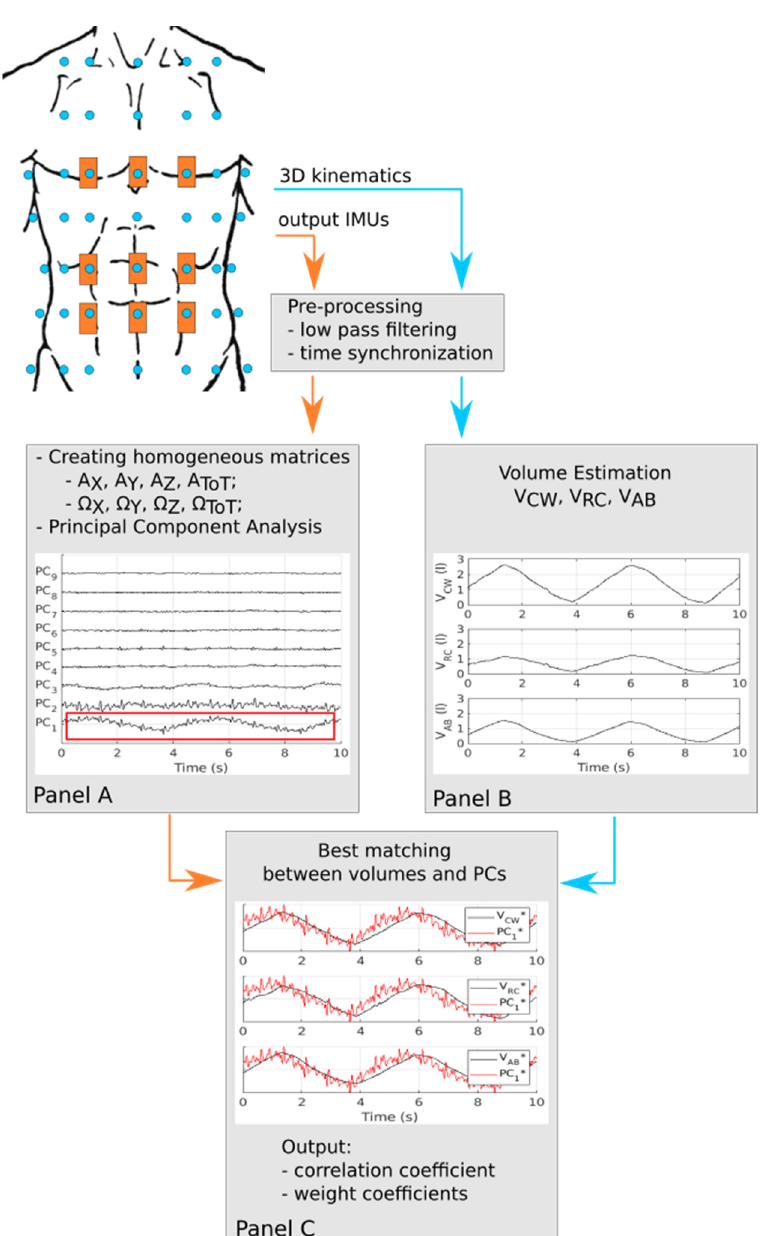
Figure 2. Summary of the algorithm that we used to identify the principal components (PCs) that best matched the time course of respiratory volumes (i.e., V CW , V RC , and V AB ). For this representative example, all data refer to the first repetition of subject #5. In addition, data reported in Panel ( A ) were computed from matrix Α X . The red box in Panel ( A ) identifies the PC that best matches (in this representative case) respiratory volumes according to the Pearson correlation coefficient. The volumes shown in Panel ( B ) are shifted along the vertical axis to set their minimum values in the whole data stream to 0. The valleys and peaks refer to onset of the inhalation and exhalation phases, respectively. The data reported in Panel ( C ) were z-scored (see apex * in the legend) to make the comparison straightforward.